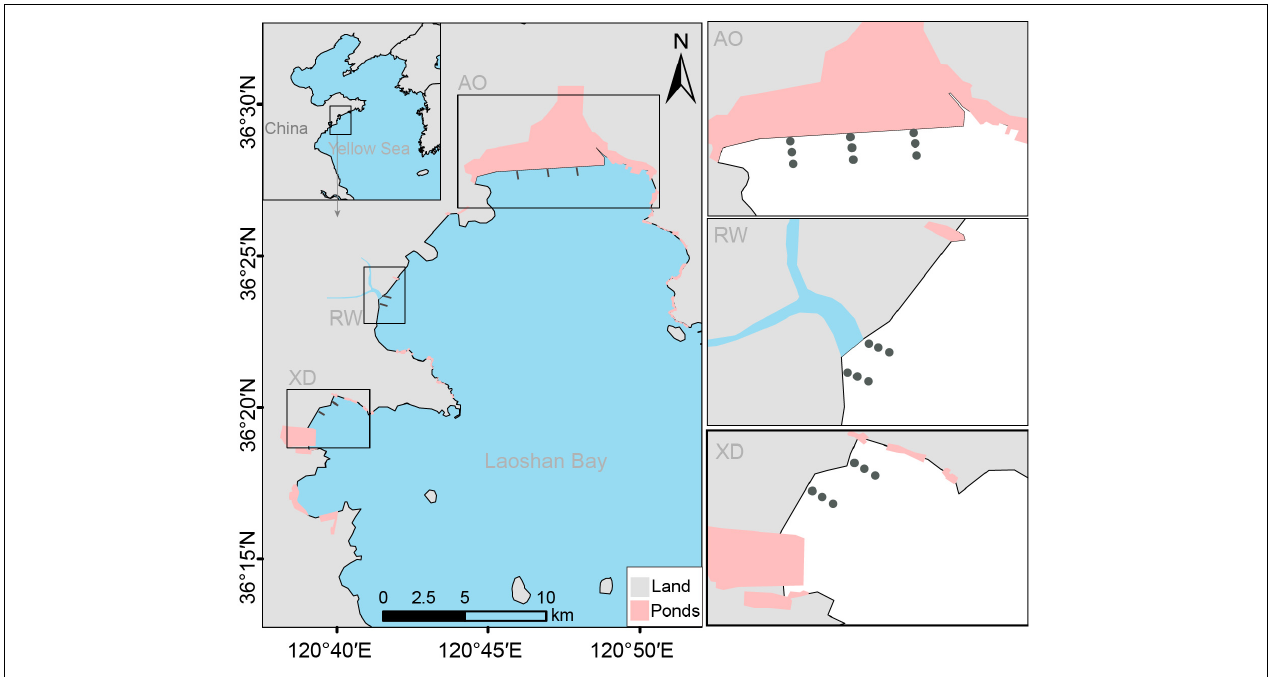
FIGURE 1 | Study area with sampled sites in three intertidal zones in Laoshan